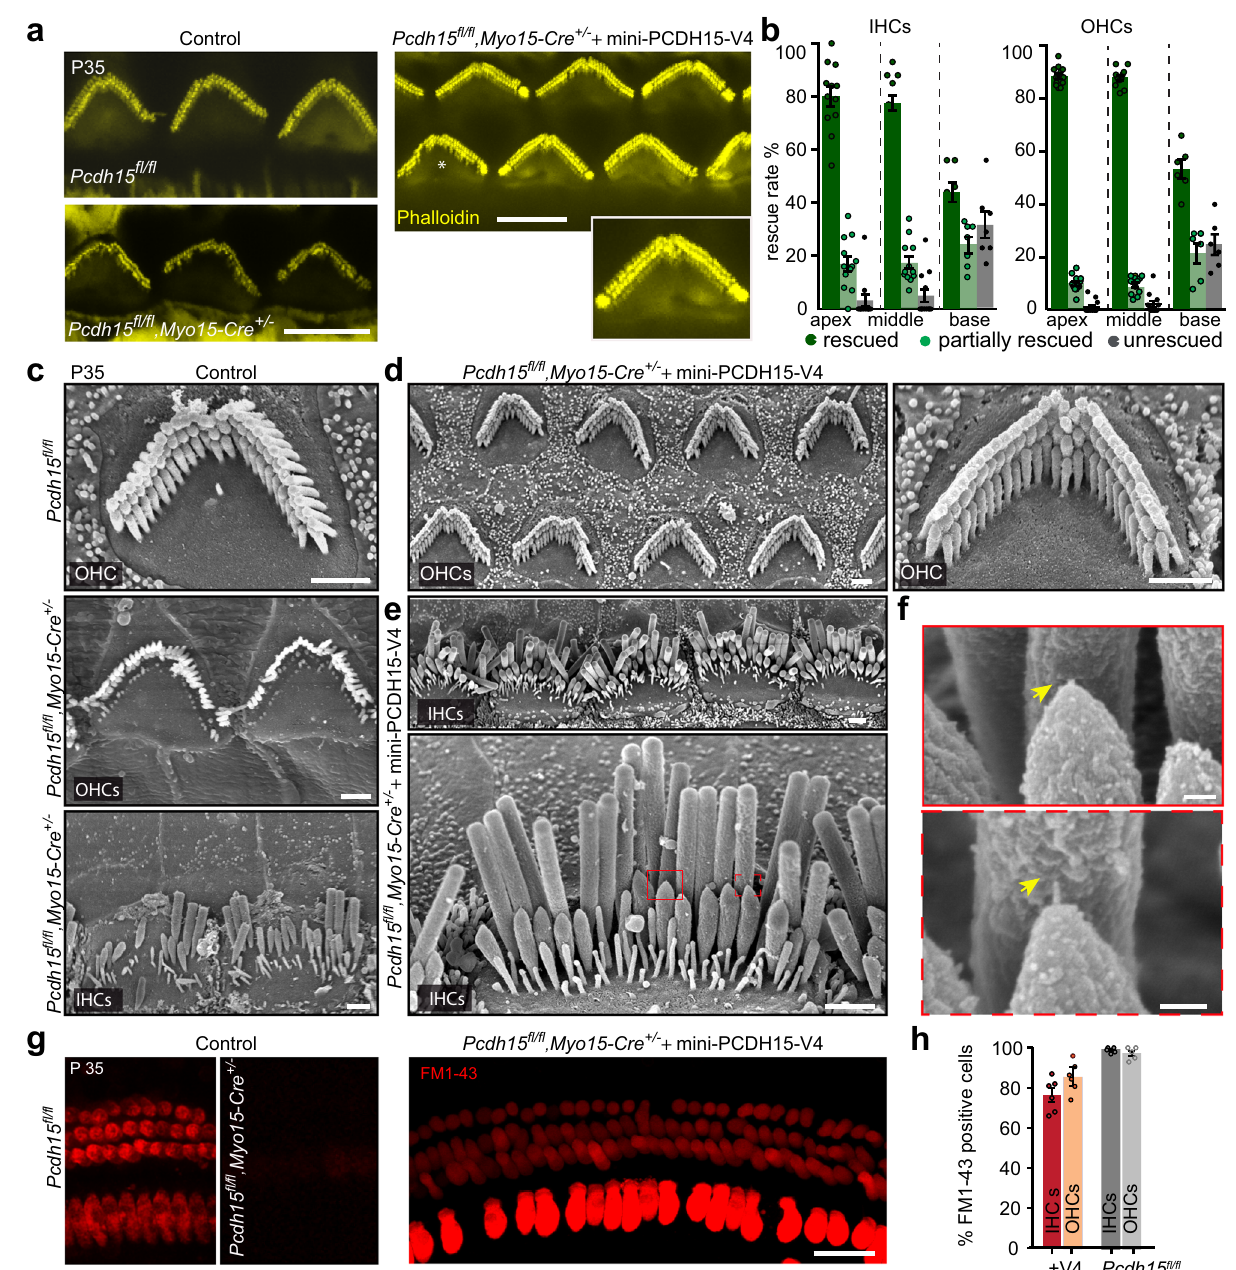
Fig. 5 | Delivery of AAV-mini-PCDH15-V4 rescues stereocilia bundle morphol- ogy and mechanotransduction. a Representative confocal microscopy images taken from the middle turn of the cochlea of P35 outer hair cells (OHCs) stained with phalloidin. Panels show Pcdh15 fl / fl hearing control mice, uninjected Myo15-Cre conditional knockout mice or knockout mice injected with AAV-mini-PCDH15-V4. Phalloidin staining (yellow) shows rescued hair bundles in injected cochleas. Asteriskindicatesatypicalpartiallyrescuedhairbundlewith>55%intactstereocilia per bundle. b Quanti fi cation of rescue rate of inner hair cells (IHCs) and OHCs in mice injected with AAV-mini-PCDH15-V4in the apical,middle, and basal regions of the cochlea ( n =12 cochleas).Data are presented asmeanvalues±SEM. c Scanning electron micrographs of single hair bundles. Panels show an OHC of a hearing control mouse and OHCs and an IHC of an untreated conditional knockout.